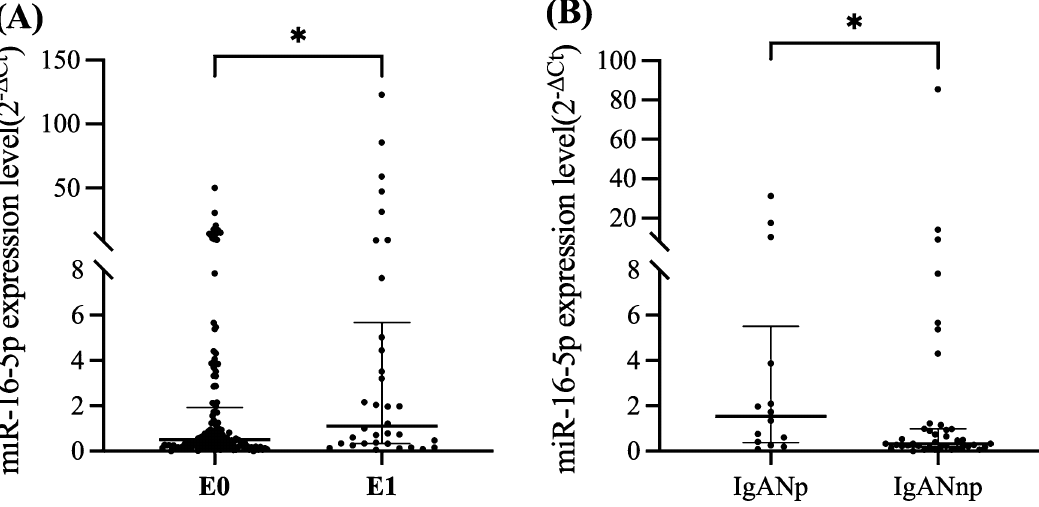
Figure 3. ( A ) Levels of urinary miR-16-5p in patients with different grade of Endocapillary hypercellularity. ( B ) Comparison of urinary sediment miR-16-5p expression levels between the IgAN progressors and non- progressors. IgANp (progressor), IgANnp